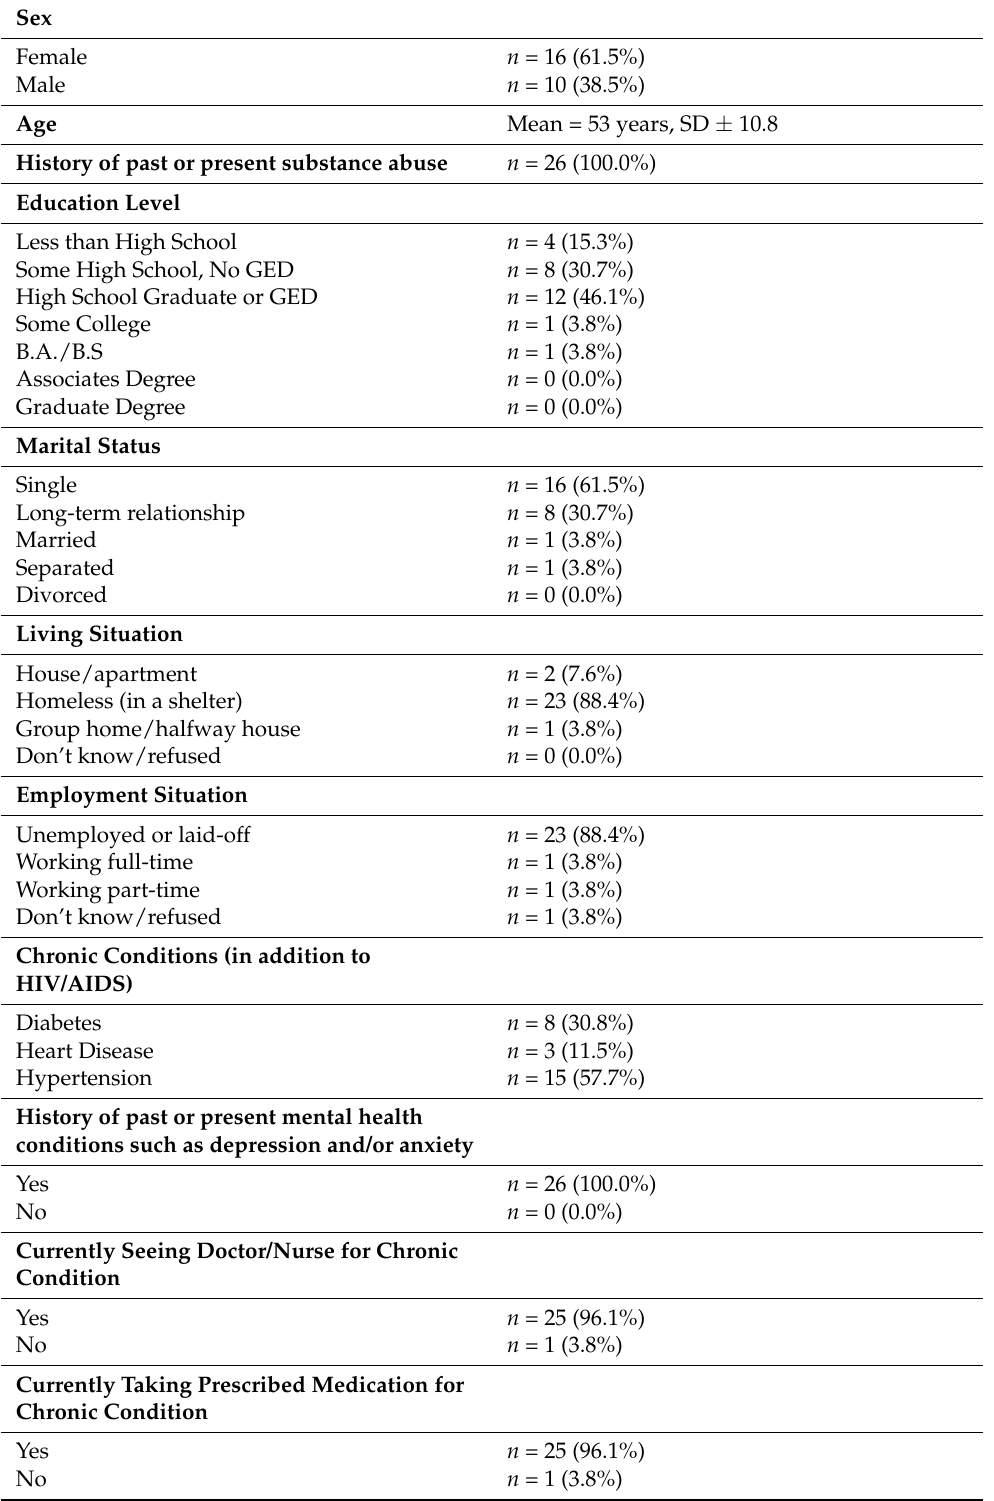
Table 2. Demographic